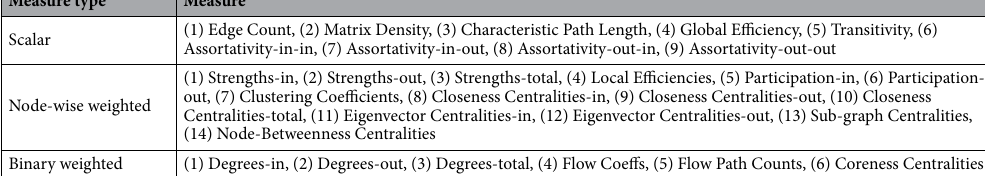
Table 1. Network measures computed. See 38 for an explanation of these